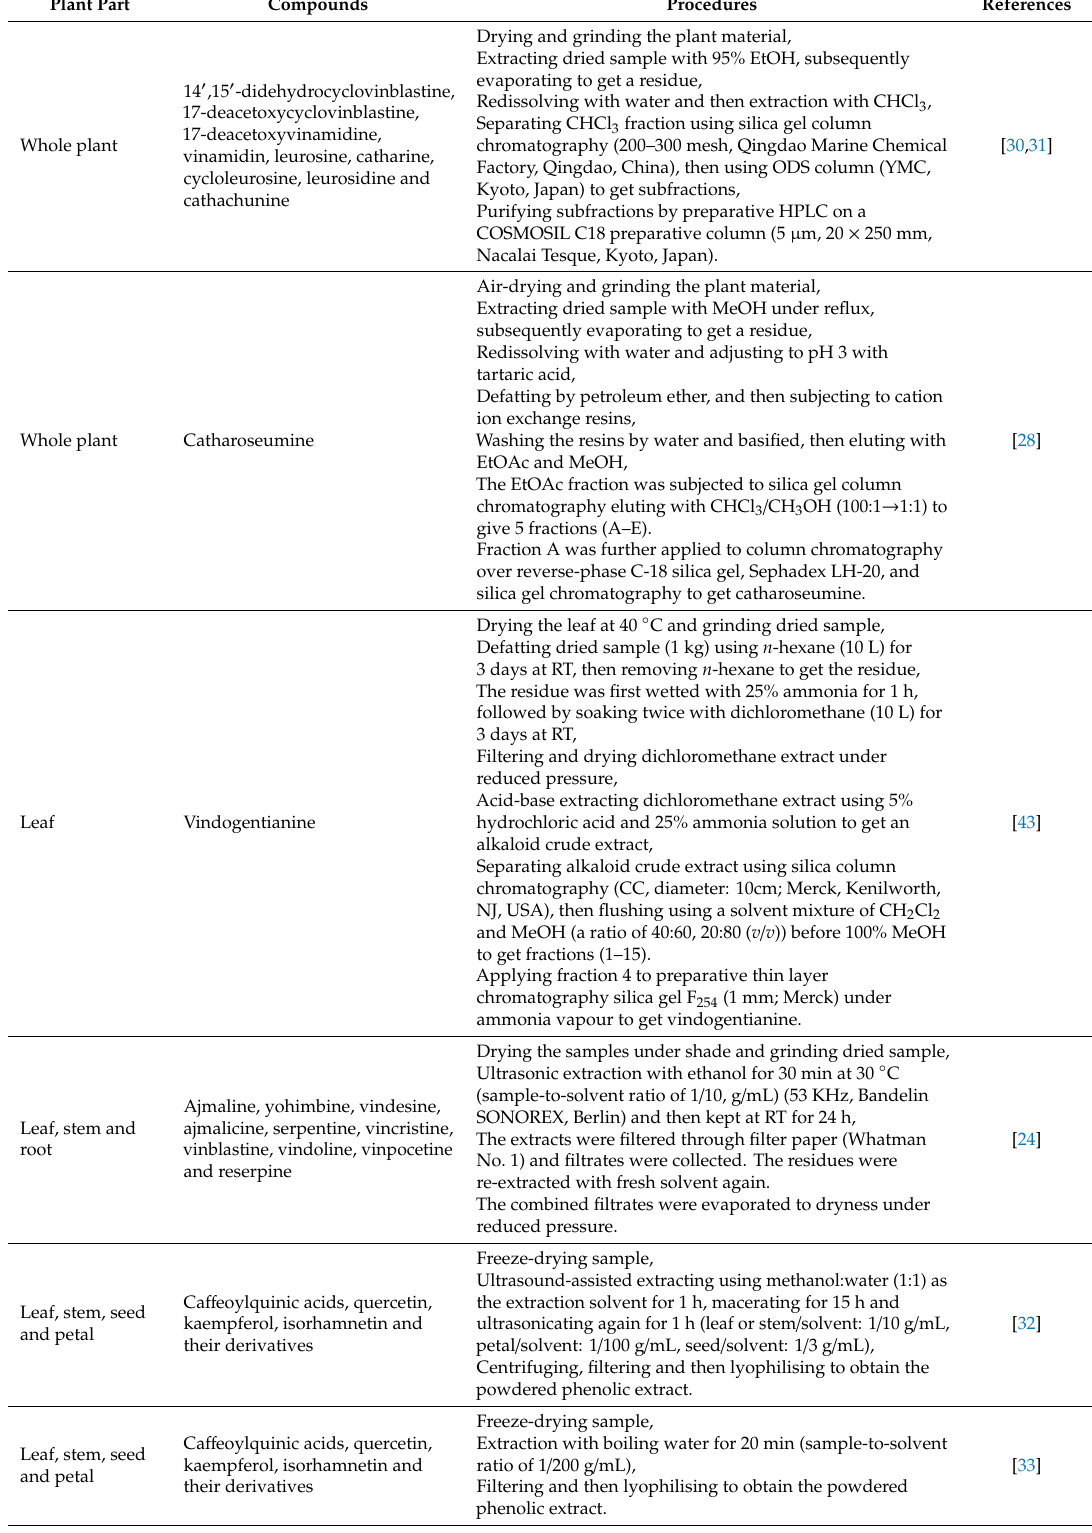
Table 5. Preparation and recovery of bioactive compounds from C. roseus